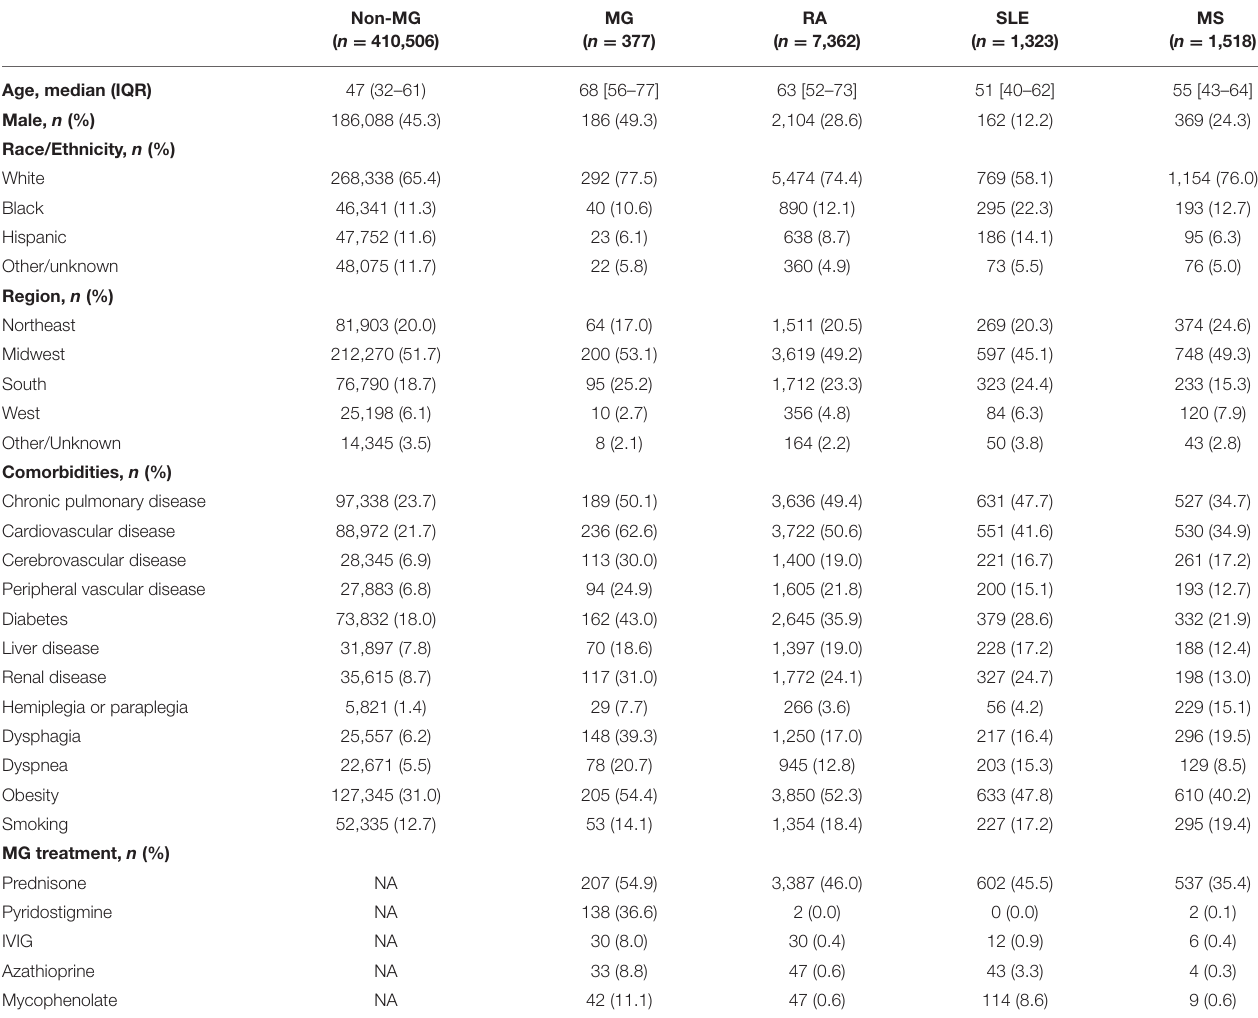
TABLE 1 | The characteristics of patients with coronavirus disease 2019